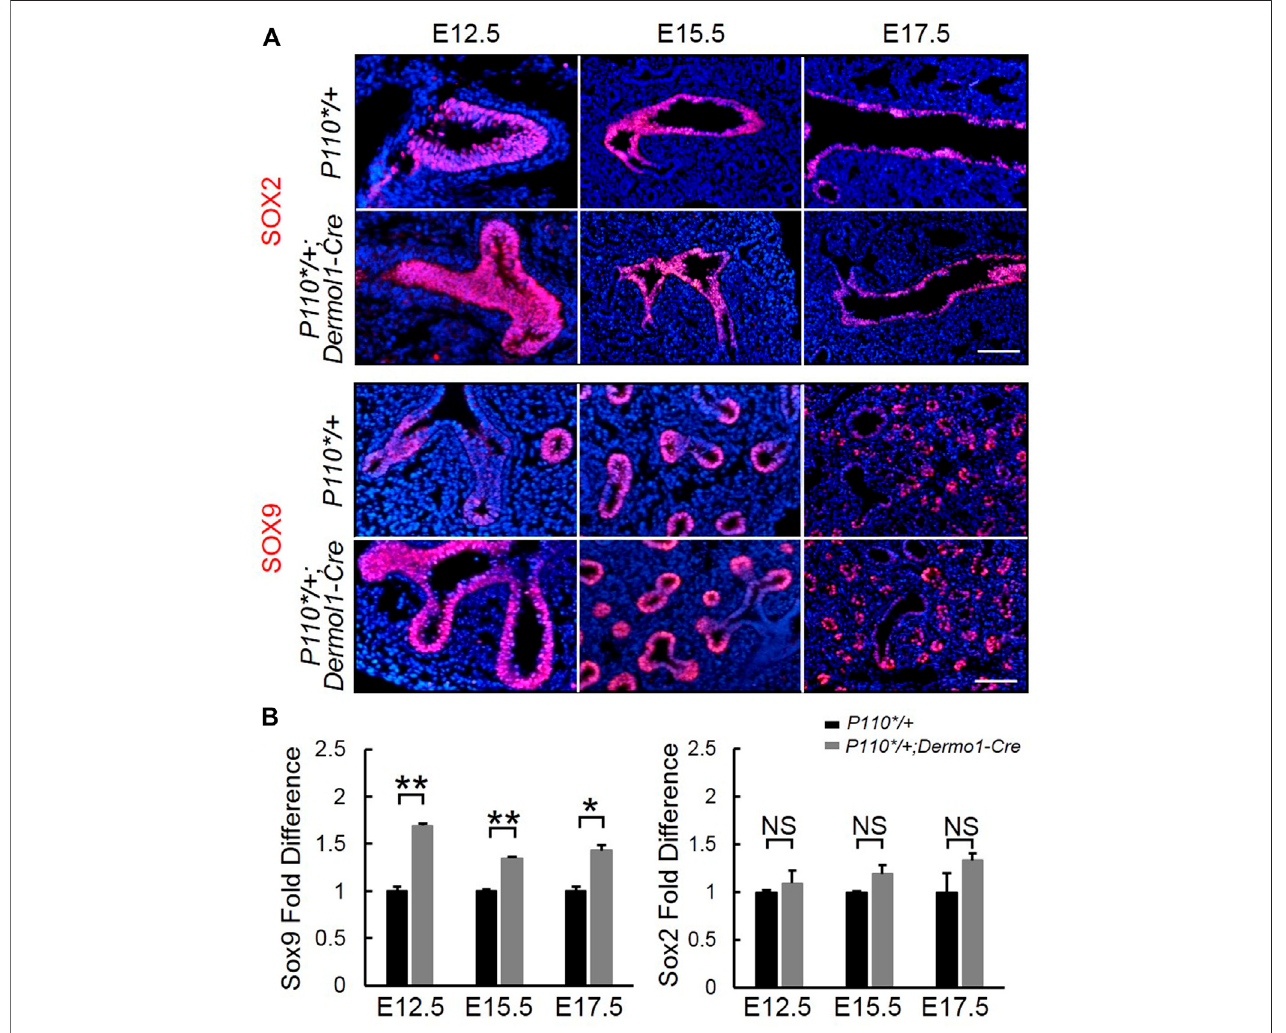
FIGURE6| Mesenchymal activation ofp110 α affectstheSOX9 expression inthe distal epithelium. IF staininganalyses (A) and real-time PCRanalyses (B) of Sox2 and Sox9 expression in E12.5, E15.5, and E17.5 control and P110*/+ ; Dermo1-cre lungs. The bars represent the mean ± SD. N > 3. *p < 0.05, ** p < 0.01 Scale bar: 50 μ